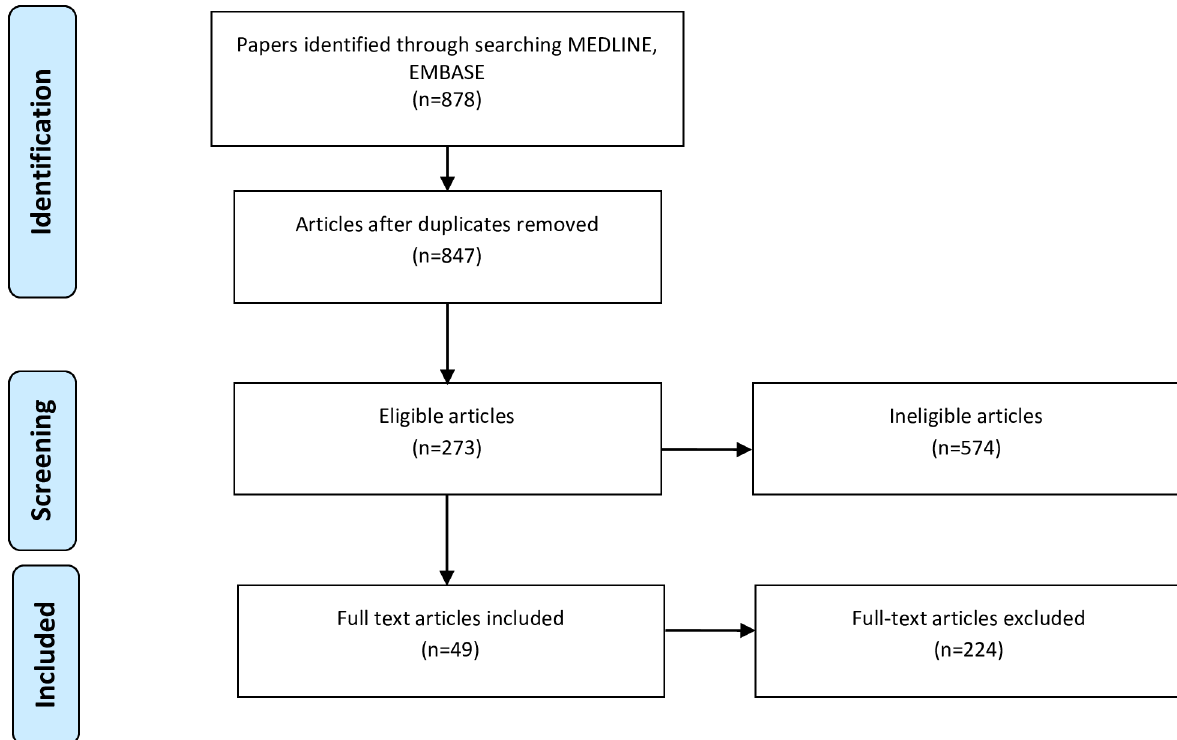
Fig 2. Flow diagram describing the systematic literature review